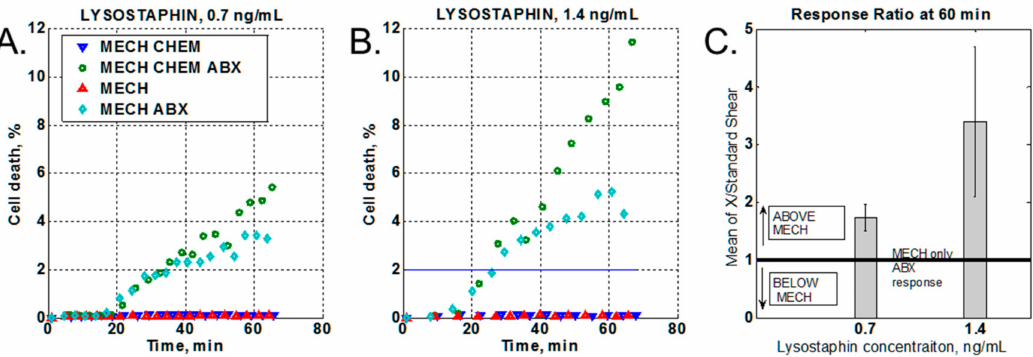
Figure 3. Chemical stressor effect. ( A , B ). Time-lapse data of cell death vs time. MECH = mechanical stress (shear flow, no lysostaphin, no oxacillin); ABX = antibiotic (oxacillin at 50 µ g/mL); CHEM = chemical stress (lysostaphin at either 0.7 ng/mL or 1.4 ng/mL). ( C ) Ratio of cell death with chemical stressor vs mechanical stress